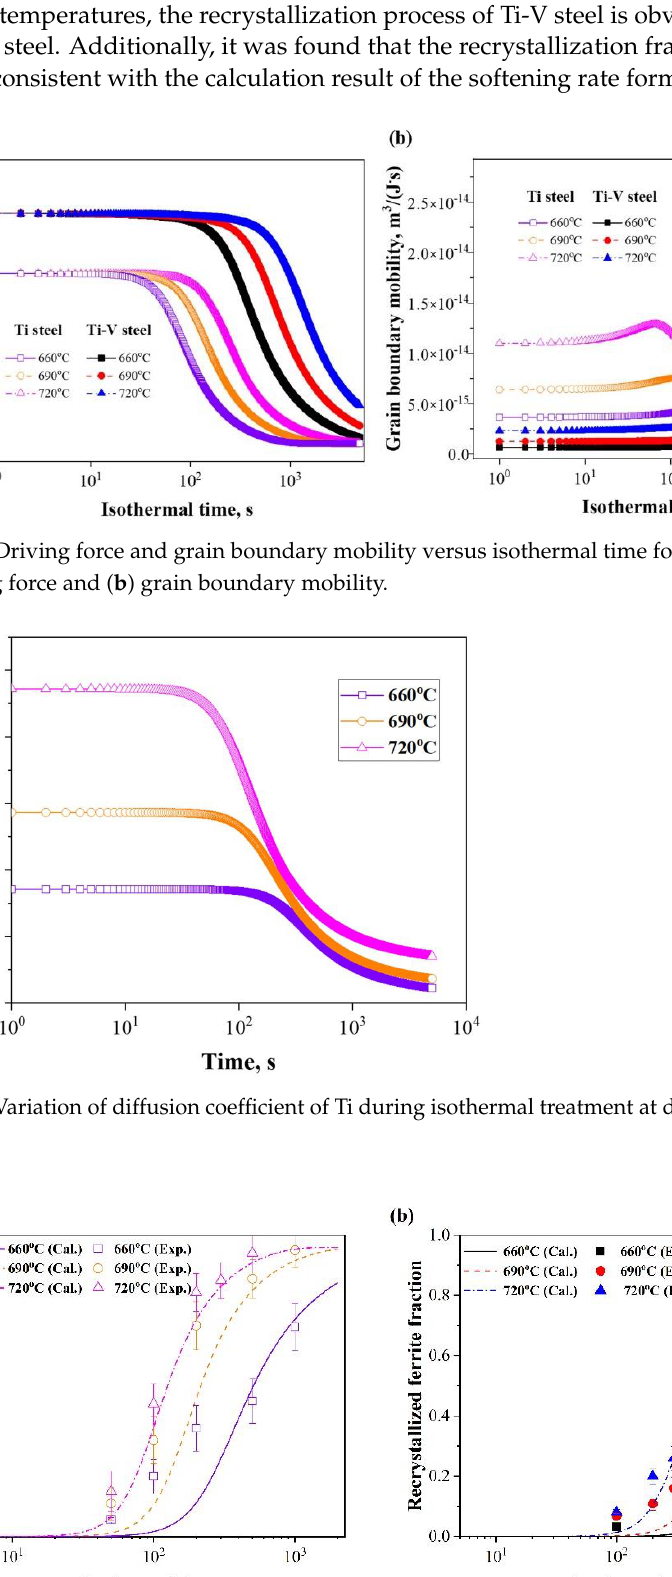
Figure 7. Comparison between calculated and measured recrystallized fraction of different steels at a series of different temperatures (660, 690, 720 °C): ( a ) Ti steel and ( b ) Ti-V steel.